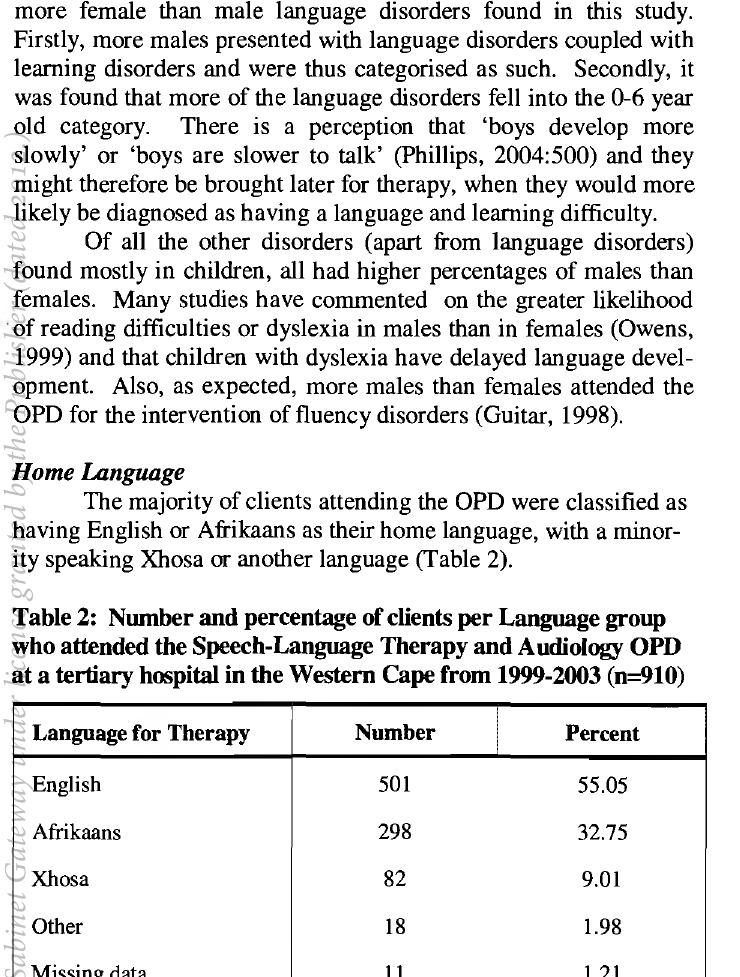
Table 2: Number and percentage of clients per Language group who attended the Speech-Language Therapy and Audiology OPD at a tertiary hospital in the Western Cape from 1999-2003 (n=910)